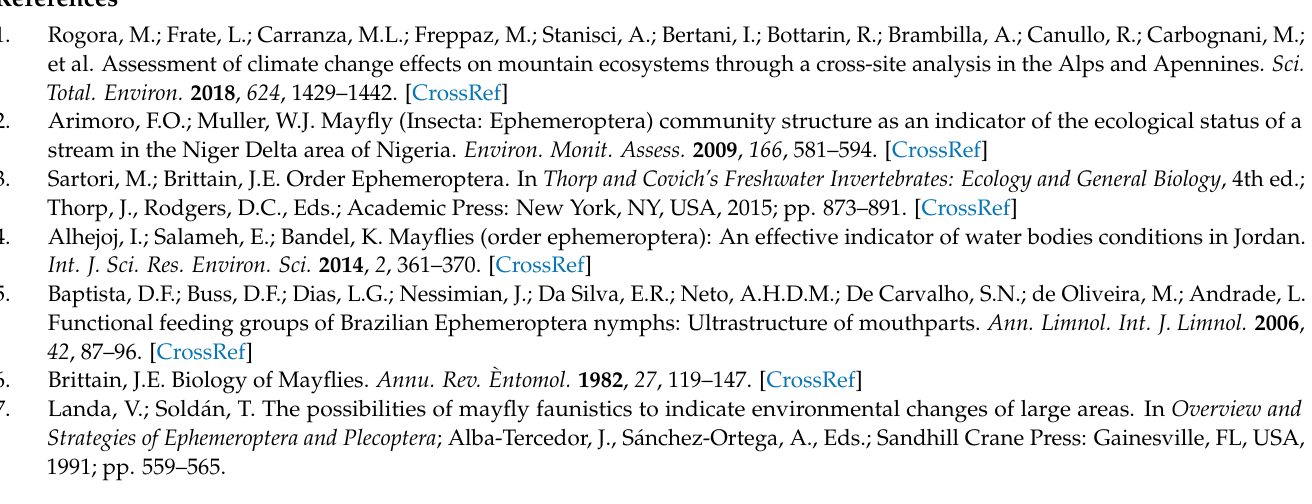
Table S3: The results of the parallel PERMANOVA and associated ANOVA in the RDA model for each environmental